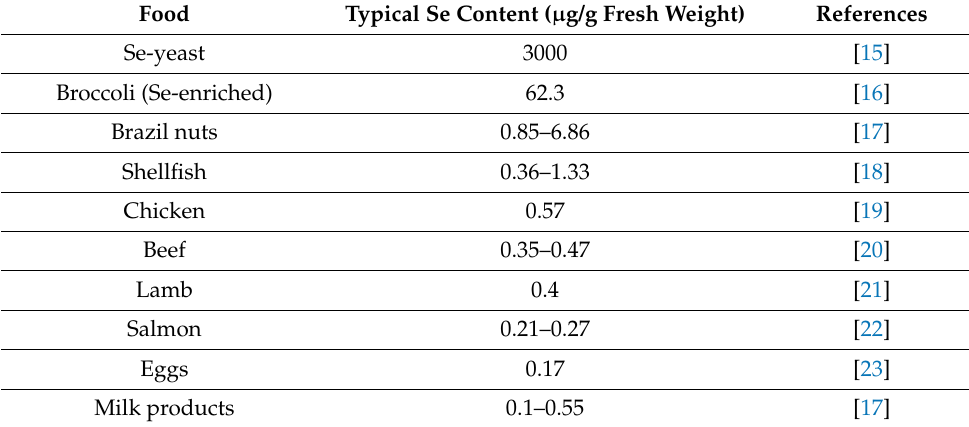
Table 1. Examples of some food products and their selenium